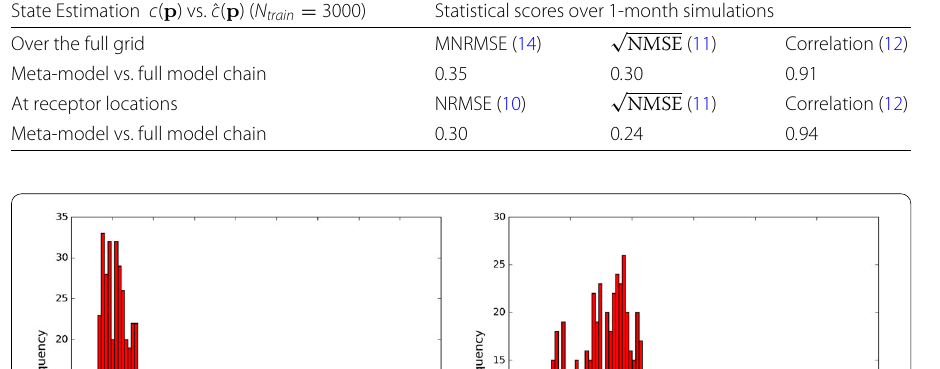
Table 4 Statistical scores of a meta-model approximation trained on N train = 3000 compared to the scores of the model chain using the full air quality model State Estimation c ( p ) vs. ˆ c ( p ) ( N train = 3000) Statistical scores over 1-month simulations